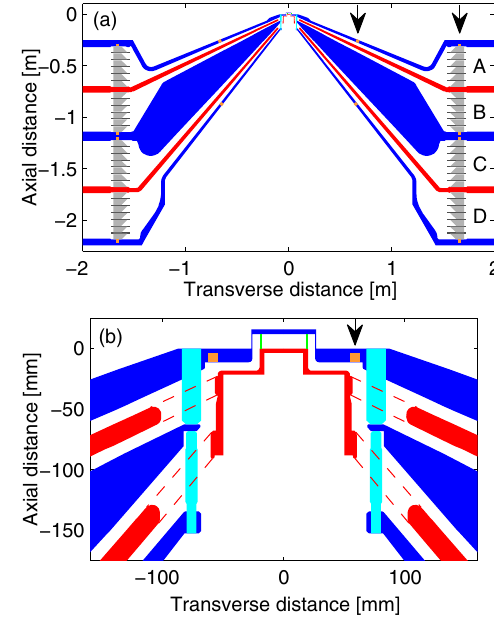
FIG. 1. (a) An R − Z cross section of the vacuum section and insulator stack of the Z machine [1]. The vacuum section contains four outer-magnetically insulated transmission lines (MITLs) labeled A through D with anodes shown in blue and cathodes in red. Arrows indicate the radial location of the outer-MITL B-dot monitors (at R ¼ 0 . 66 m on the A and D levels) and the stack B-dot and D-dot monitors (at R ¼ 1 . 66 m on the A, B, C, and D levels). (b) An R − Z cross section of the double post-hole convolute with the z-pinch dynamic-hohlraum [12,13] load geometry. Anodes are shown in blue, convolute anode posts in cyan, cathodes in red, and holes in the cathode are represented by dashed red lines. An arrow indicates the radial location of the inner-MITL B-dot monitors (tan squares). The inner-MITL region ( R < 58 mm) varies with load type.